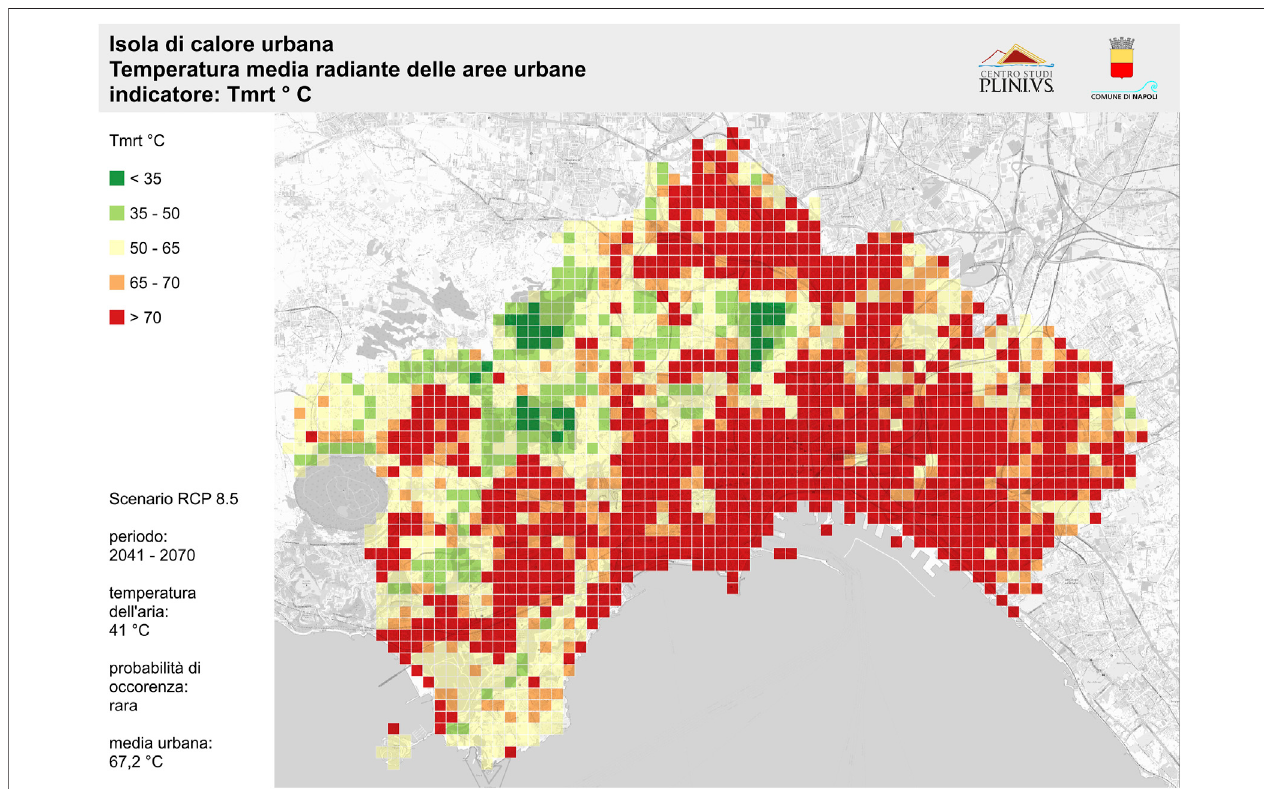
FIGURE 9 | Hazard local effect results for Naples municipality from HWLEM. Tmrt values correspond to a “ rare ” event in the period 2041 – 2070, RCP 8.5.